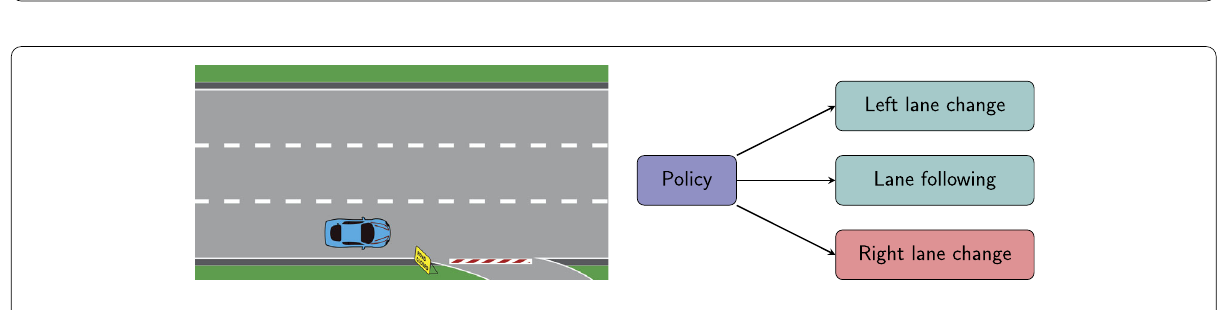
Figure 7 Masking prevents from undertaking undesirable actions (red)